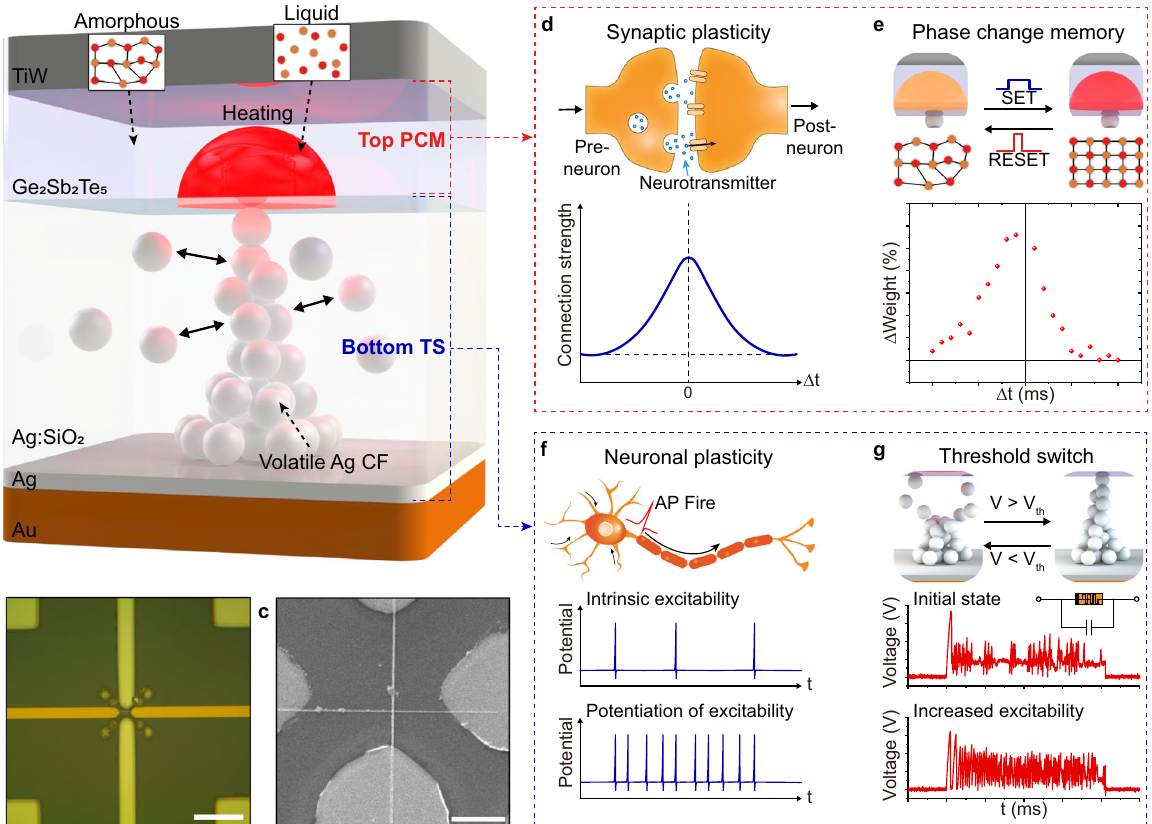
Fig. 1 Structure of TS-PCM composed of volatile TS and nonvolatile PCM layers. a Schematic diagram of TS-PCM composed of volatile TS and nonvolatile PCM layer. The phase transition of the top PCM layer is regulated by the Ag fi lament formation in the bottom TS layer. b Optical microscope image of fabricated TS-PCM cell. Scale bar, 10 μ m. c SEM image of TS-PCM showing the nanopatterned electrodes via EBL process. Scale bar, 5 μ m. d Illustration of biological synapse with emission neurotransmitters (upper panel). A representative example of STDP is shown in the lower panel. e Schematic diagram of PCM with the phase transition process (upper panel). The lower panel demonstrates the emulation of STDP by TS-PCM. f Illustration of a biological neuron that integrates input signals into an AP spike (upper panel). The lower panel shows the neuronal intrinsic plasticity of neuron. g Schematic diagram of TS device presenting the formation and rupture of Ag fi lament (upper panel). The lower panel demonstrates the emulation of intrinsic plasticity by TS-PCM and a parallel PCM exhibits nonvolatile resistive switching, as demonstrated in Fig. 2b. The as-deposited GST fi lm is in an amorphous phase with high resistance of 1.11 × 10 4 Ω , that changes to a crystalline phase by Joule heating during the voltage sweep. The operation current of PCM is dependent on the size of Joule heating element, which shows a dramatic decrease with the adoption of a conductive fi lament nanoheater, as reported in our previous paper 31 . The TS-PCM device is fabricated by combining two distinctive volatile and nonvolatile memristive devices without intermediate electrodes between them. Because of the coexisting nonvolatile- volatile characteristics of TS-PCM, four different states are observed during the voltage-sweep operation, as shown in Fig. 2c, d. In the initial stage (i), the bottom TS and top PCM layers are in the OFF state, demonstrating high resistance over 3 × 10 7 Ω . The bottom TS layer is switched to the ON state in stage (ii) by applying an electric fi eld above V 6 Ω . The th , presenting relatively low resistance of 8 × 10 top PCM layer still remains in the OFF state in stage (ii), since the applied current during the 0-1 V voltage-sweep is insuf fi cient to induce the phase transition of GST fi lm. After the voltage sweep, TS-PCM is switched back to stage (i), presenting the volatility of the TS-PCM device. The PCM layer is changed to the ON state by application of a SET pulse (2 V, 200 ms), that leads to a transition to stage (iii). The TS-PCM in stage (iii) demonstrates high resistance of 9 × 10 6 Ω , due to the TS layer being in the OFF state. A voltage